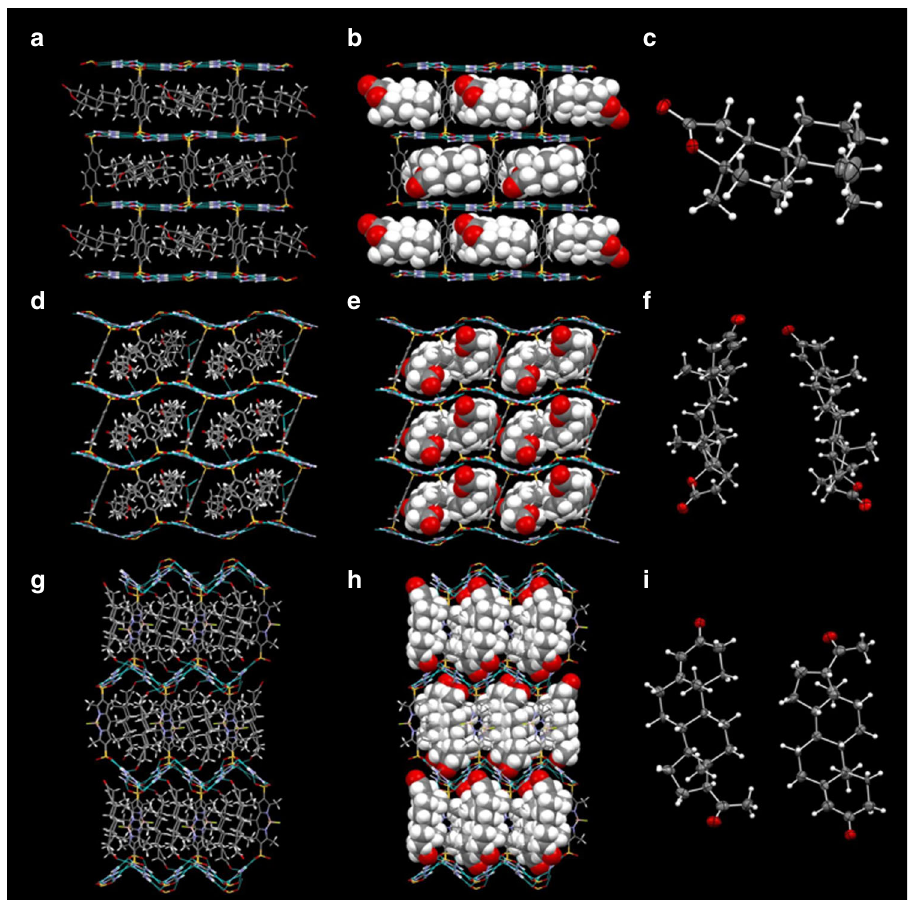
Fig. 4 Illustrative crystal structures of GS inclusion compounds. These are depicted as stick fi gures that illustrate the 100% occupancy (left panel), the target guest molecules as space fi lling (center), and ORTEP representations of the guests. a – c (G 2 NDS) ⊃ (3aR)-( + )-Sclareolide ( 5 ); d – f (G 2 NDS) ⊃ (drospirenone)(methanol) 0.84 (H 2 O) 0.1 ( 6 ); g – i (G 2 BDPYDS) ⊃ (progesterone) ( 7b ). The stick renderings in the leftmost panels reveal the 100%